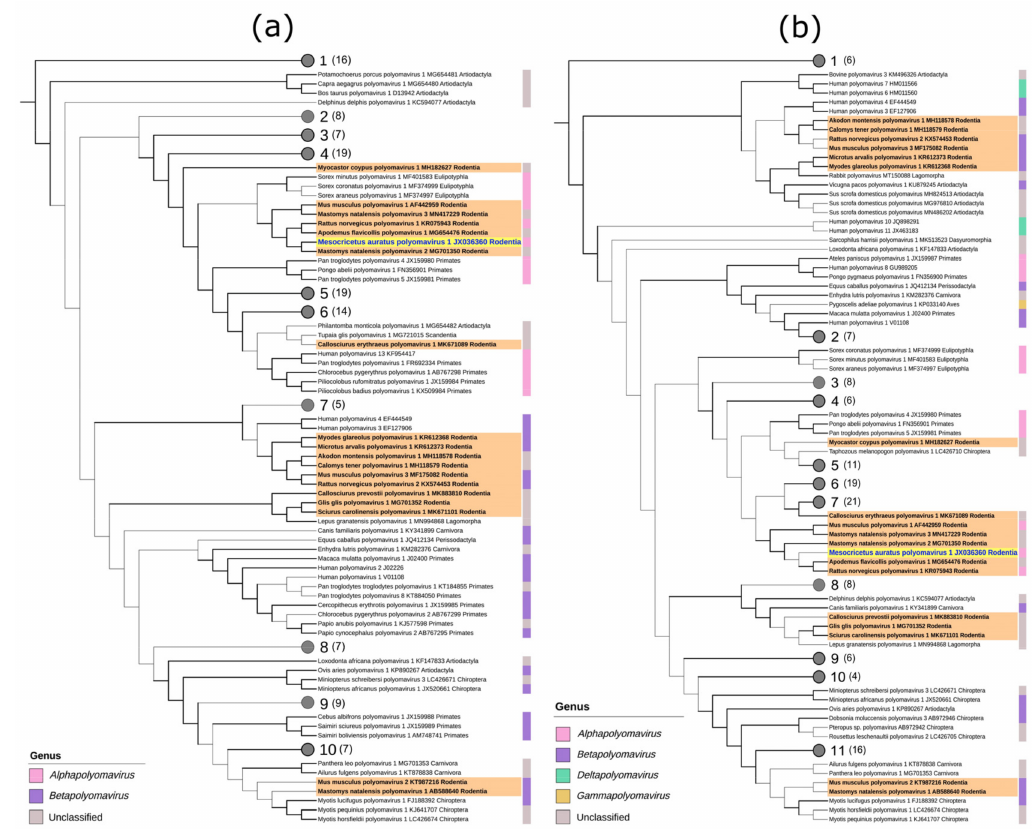
Figure 3. Phylogenetic trees of 174 representatives of the Polyomaviridae family obtained using LT ( a ) and VP1 ( b ) amino acid sequence alignments. Polyomaviruses are named following the recommendations of the International Committee on Taxonomy of Viruses (ICTV), accession numbers of sequences are provided. Virus genera are indicated by a colored stripe on the right side of each tree and the orders of the viral hosts are given. Rodent polyomaviruses are depicted in bold font with an orange background, hamster polyomavirus is emphasized with a bright yellow background. Trees were generated using a maximum likelihood analysis, Transfer Bootstrap Expectation support for bold black branches is >0.85. The number of leaves in condensed nodes are given in parenthesis. Detailed information on condensed nodes and tree generation and quoted references are given in Supplementary Table S1